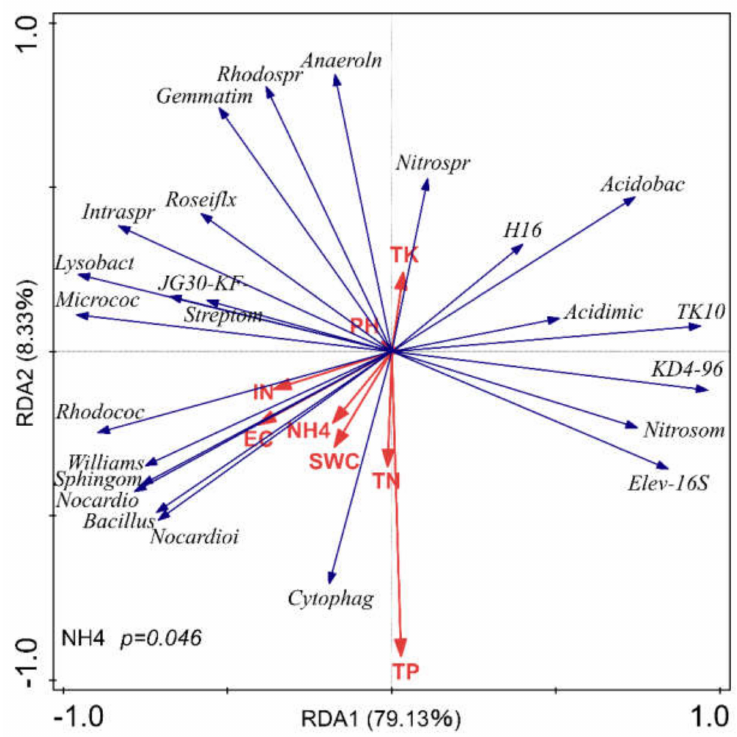
Figure 4. Redundancy analysis (RDA) of the composition of soil bacterial community at the genus level and soil physiochemical properties. Bacterial genera are represented by blue lines, and soil physiochemical properties (environmental factors) are represented by red lines. (TK: